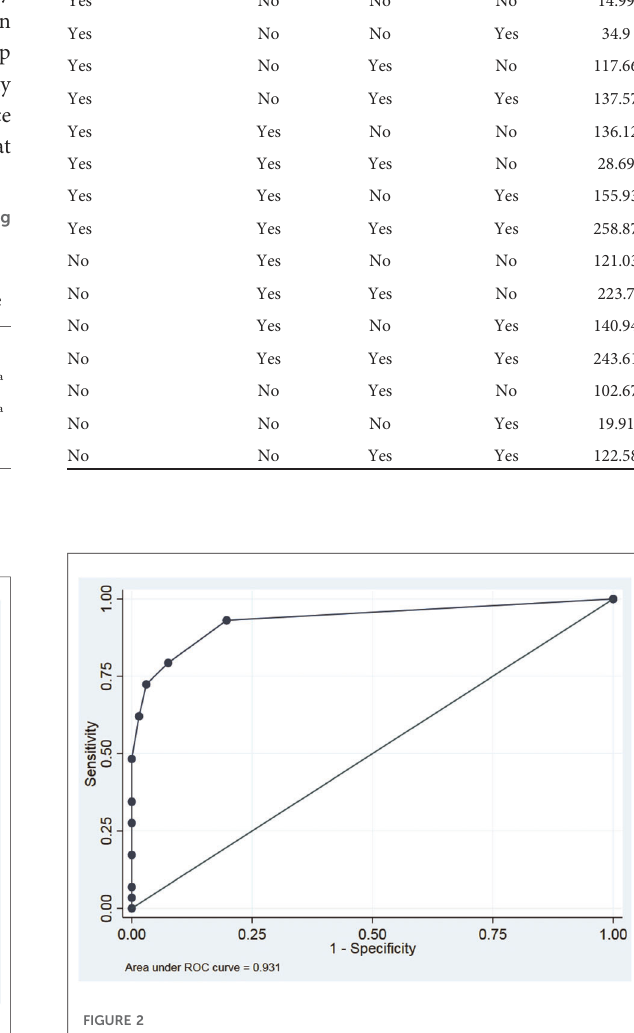
FIGURE 1 Odds ratio of 4 remained variables.